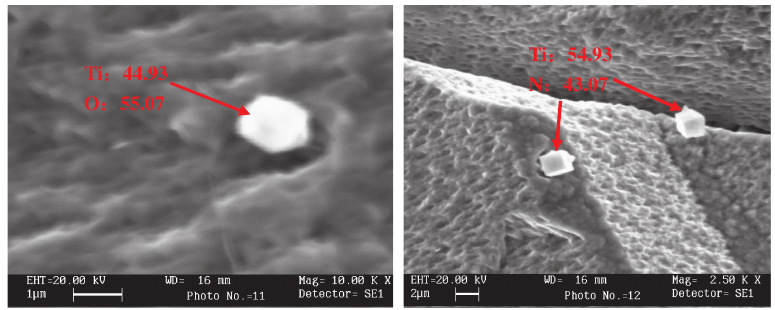
Figure 4: Morphology of composite core-containing